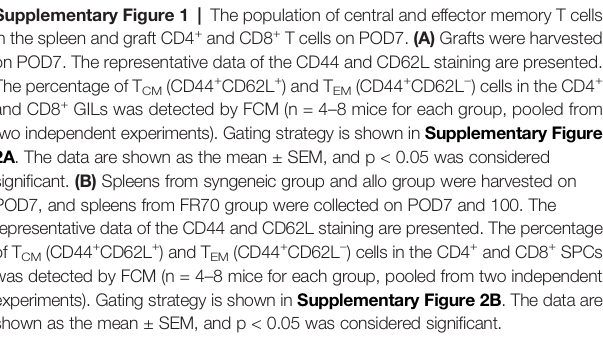
experiments). Gating strategy is shown in Supplementary Figure 2B . The data are shown as the mean ± SEM, and p < 0.05 was considered signi fi cant. Supplementary Figure 2 | Gating strategy for the fl ow cytometric analysis of lymphocytes from graft and spleen. (A) Gating strategy for lymphocyte analysis in graft. Doublets were discriminated based on SSC-H and SSC-W, and CD45 positive cells were determined in singlets. Next, living cells were gated on CD45 + cells, and then CD3 + cells were gated on living cells. Finally, CD3 + cells were gated for CD4 + and CD8 + cells. (B) Gating strategy for lymphocyte analysis in